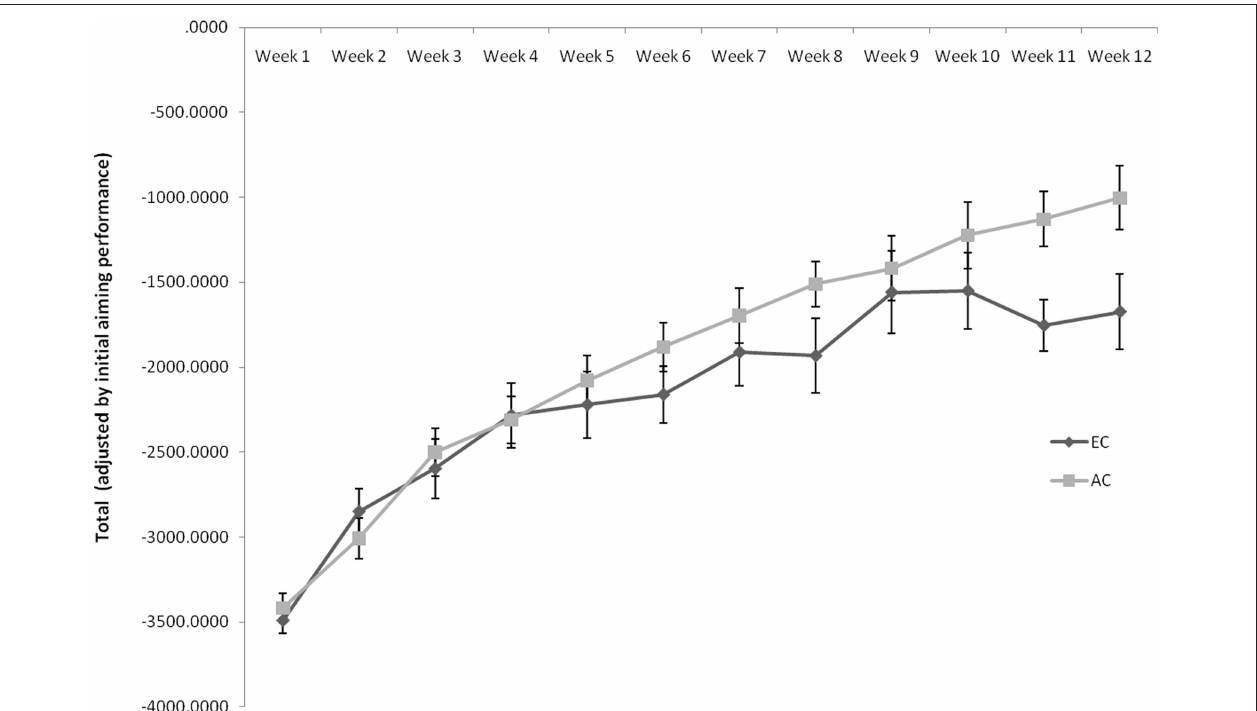
FiGurE 2 | Total SF performance as a function of training instruction (EC vs. Standard), adjusted by subject-specific aiming